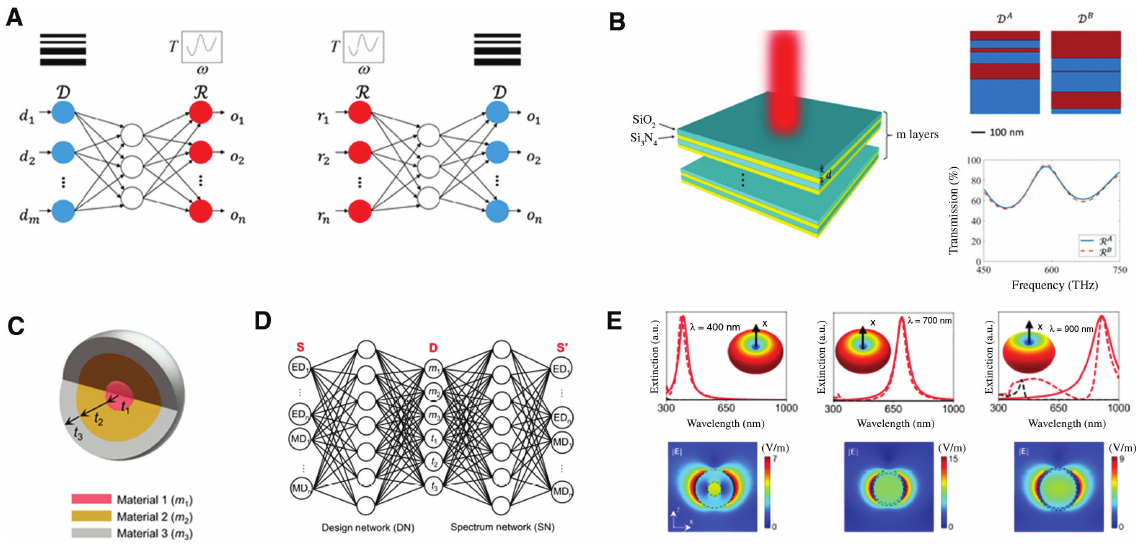
Figure 3: Inverse design in nanophotonics via DL. (A) Schematics of forward model and inverse model. (B) A schematic of the SiO same transmission response. (C) A schematic of Core-shell nanoparticle and (D) corresponding DL model to simultaneously design